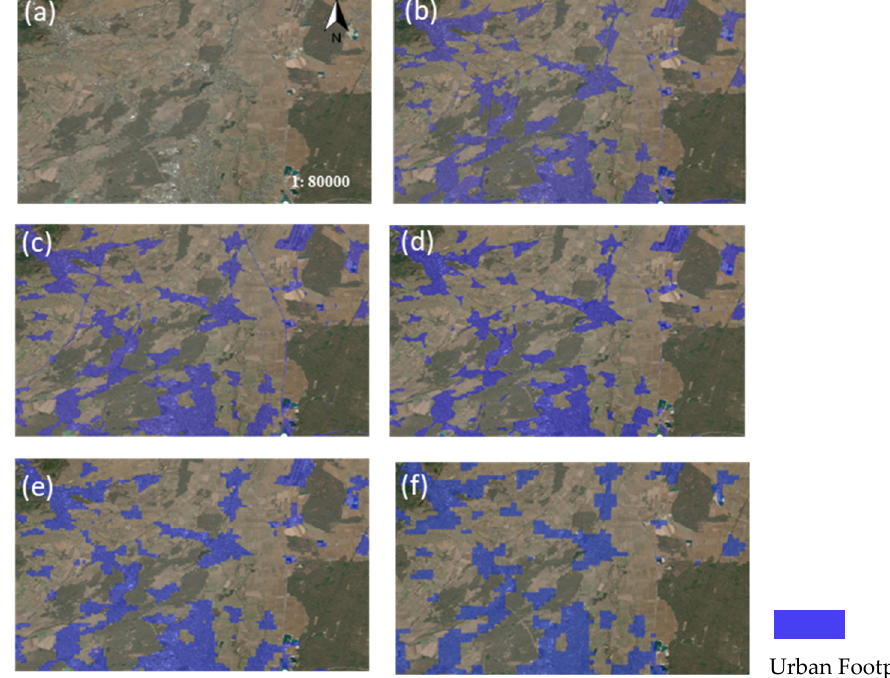
Figure 10. The class of urban footprint (in blue) as predicted by each model at a scale of 1/80000: ( a ) portion